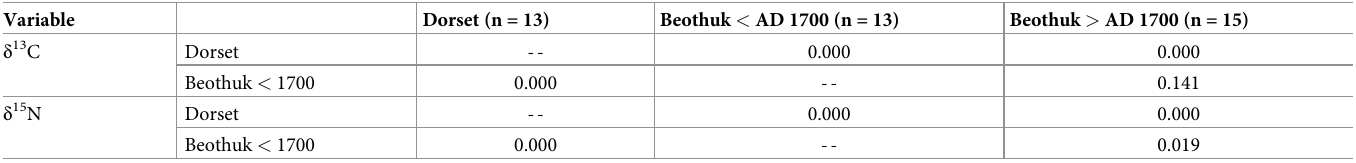
Table 2. Results of Dunnett’s T3 post hoc comparison between chronological groups. Variable Dorset (n = 13) Beothuk < AD 1700 (n = 13) Beothuk > AD 1700 (n = 15)